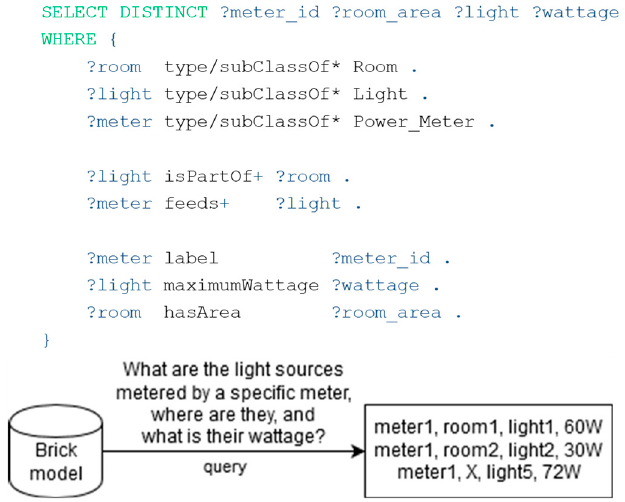
Figure 9. Query for collecting per light maximum wattages. The wattages are summed up per meter in post processing.